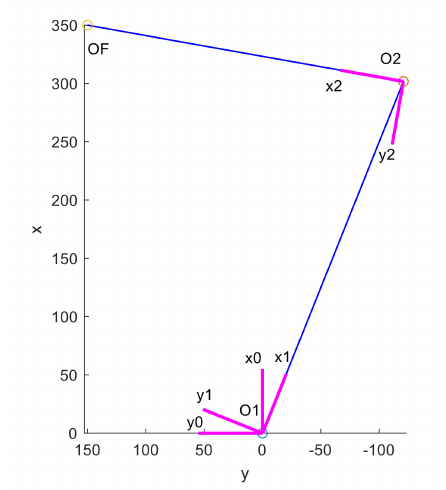
Figure 2. The kinematic scheme of the SCARA